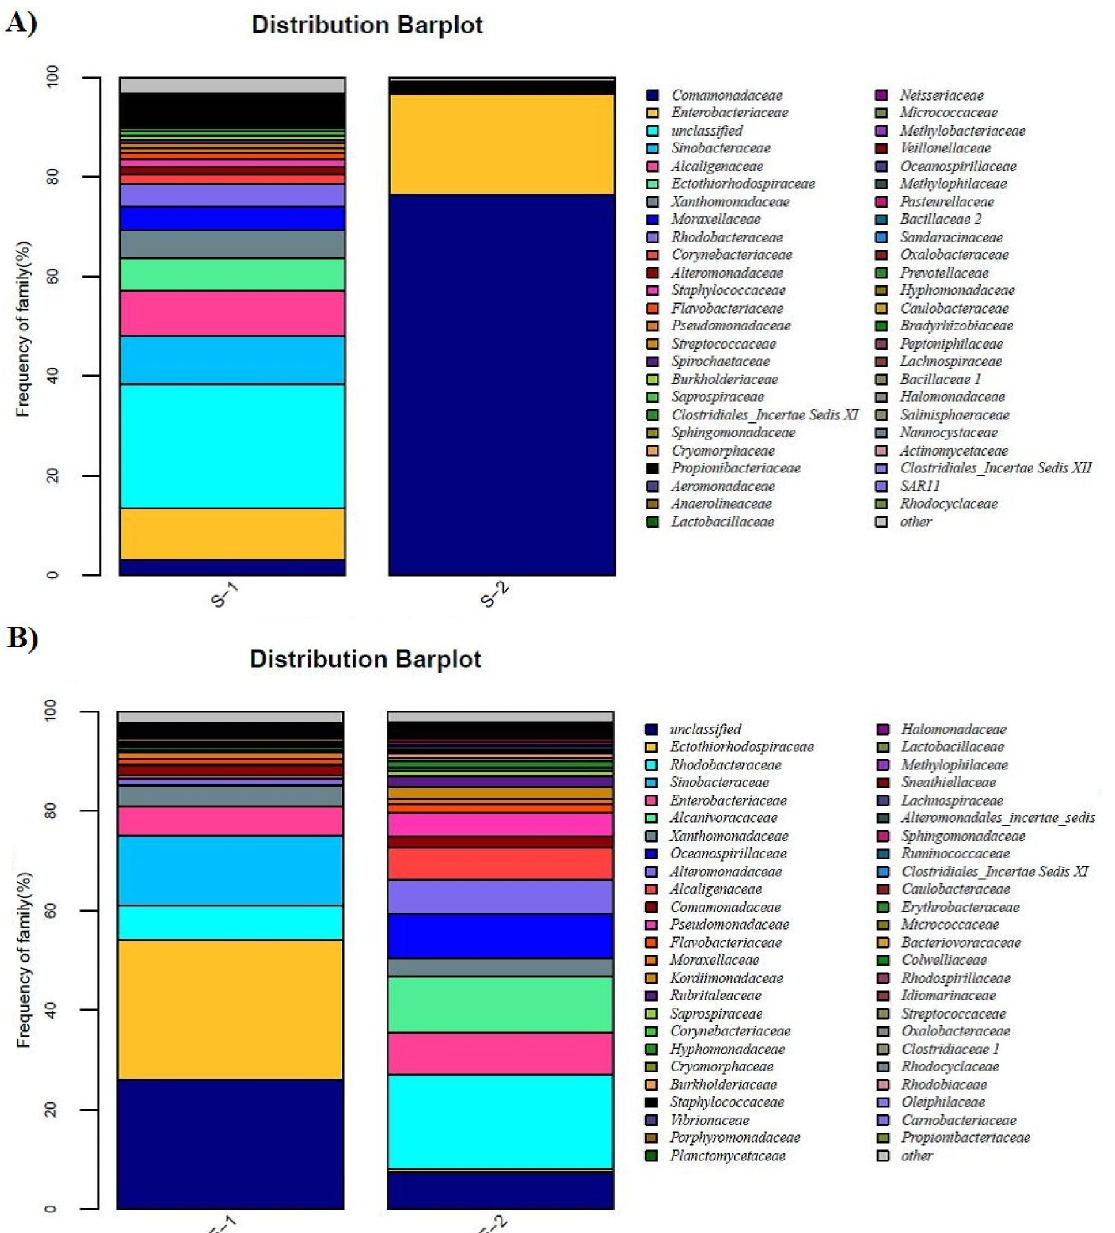
Fig. 4. Histogram of the changes in the internal symbiotic bacterial communities of the two corals before and after heat treatment. Different colors represent different genus, cannot be identified with unclassified representatives, low abundance with other